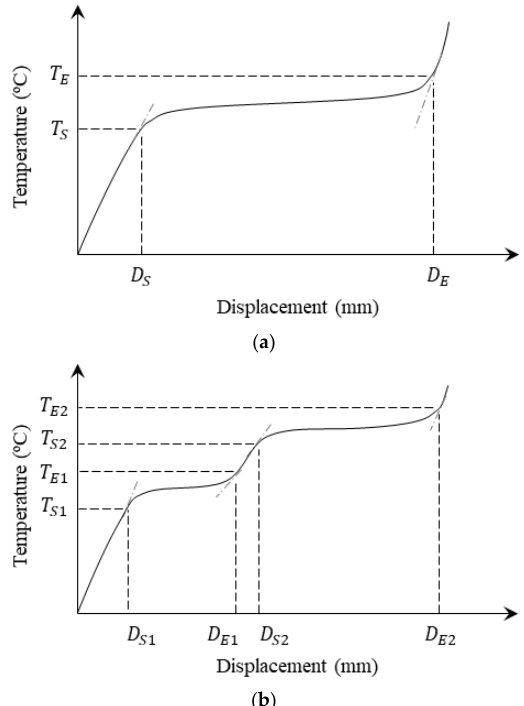
Figure 7. Notations of characteristic value in heating temperature–displacement curves: ( a ) single wire and ( b ) hybrid wire.